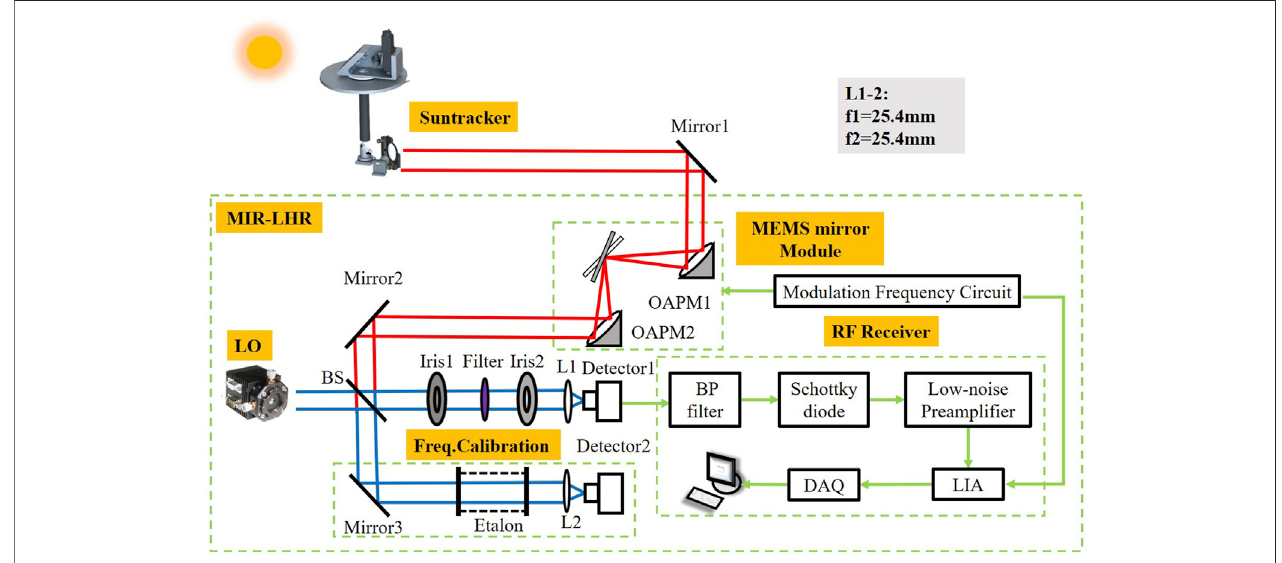
FIGURE 1 | Schematic of the developed MIR-LHR. BS: beam splitter; BP: band-pass; RF: radio frequency; DAQ: data acquisition card; LIA: lock-in ampli fi er; L: lens; OAPM: off-axis parabolic mirror.